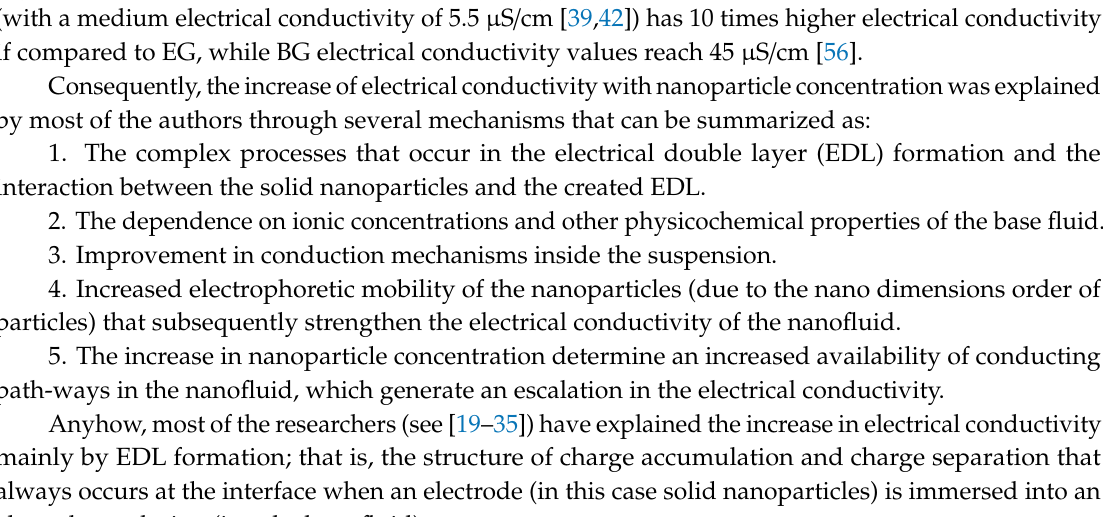
Figure 5. Comparison of data on alumina nanofluids with different base fluids [41,51,55,56].